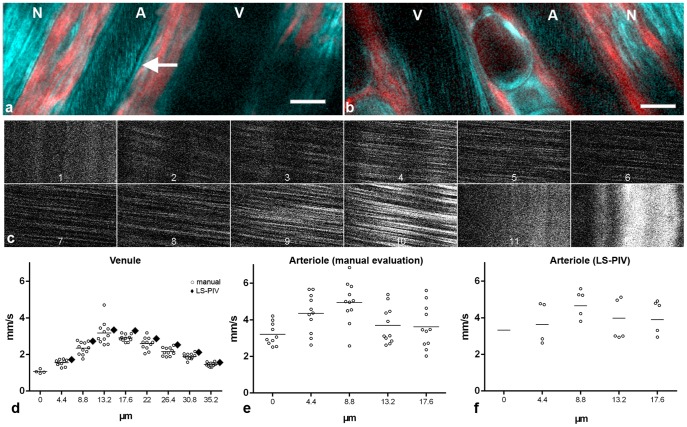
THG microscopy in the mouse ear.(a,b) Intravital imaging in different animals with arteriole (A), venule (V) and nerve fiber (N) running in parallel. In addition to the THG signal (cyan) SHG (red) is displayed. The arrow points to a typical linear vessel wall signal found only in arterioles. Scale bars 20 µm. The declining THG signal strength in more axial parts of a vessel are easiest to recognize in the arteriole in (a) and the venule in (b). (c–e) Flow velocity profile measurements by THG shifted line scan in the venule shown in b. (c) Clippings from x-t-representations of 12 parallel scan lines spaced 4.4 µm from each other. Lines 1, 11 and 12 were located in the vessel wall and thus show no movement. Note the shallower angles (faster velocity) and decreased intensity in the central scans. (d) Measurements derived from c by manual evaluation of individual streaks (circles) with mean values (horizontal lines) and mean values from LS-PIV calculations (diamonds). Scan lines 2 (0 µm) to 10 (35.2 µm) from (c) are included. Manually measured velocities revealed significant differences between the scan lines (p<0.0001, ANOVA) with significant differences between all direct neighbors (p<0.05 or smaller, post hoc Newman-Keuls test). For scan line 2 (0 µm), only a part of the x-t-representation showed blood flow. Apparently this line was close to the vessel wall so that slight movement could shift it outside. No reasonable LS-PIV average could thus be obtained. LS-PIV evaluations of the other scan lines confirmed significantly different blood flow velocities in general (p<0.0001; ANOVA, n = 88 for each line) and for all direct neighbors (****), except for the two central lines. (e) Measurements by manual evaluation for the arteriole shown in (b) Velocity measurements were significantly different between 0 and 4.4 µm lines (p = 0.0075) and between 8.8 and 13.2 µm lines (p = 0.0129). (f) LS-PIV results for the same arteriole. Only systolic maxima and diastolic minima (circles) and the mean values over all 3.2-millisecond-spaced 179 measurements (line) are shown. In the first scan line systole and diastole could not be identified reliably, therefore only the mean is given. Velocity differences between neighboring scan lines were all significant (p<0.0001) except between 13.2 and 17.6 µm (p = 0.87).